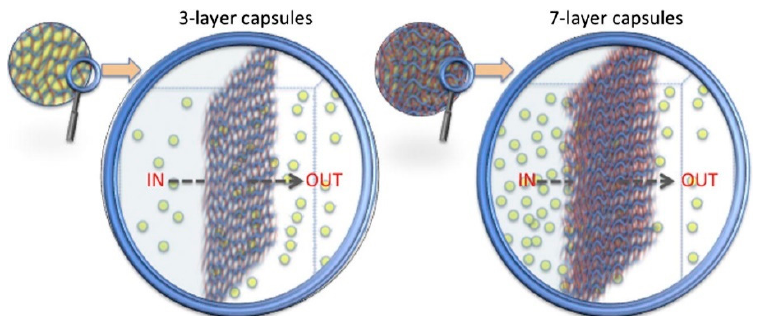
Figure 2. A schematic representation of the effect of the multishell thickness on the molecule release (reproduced with permission from [42], Copyright 2015, Elsevier).